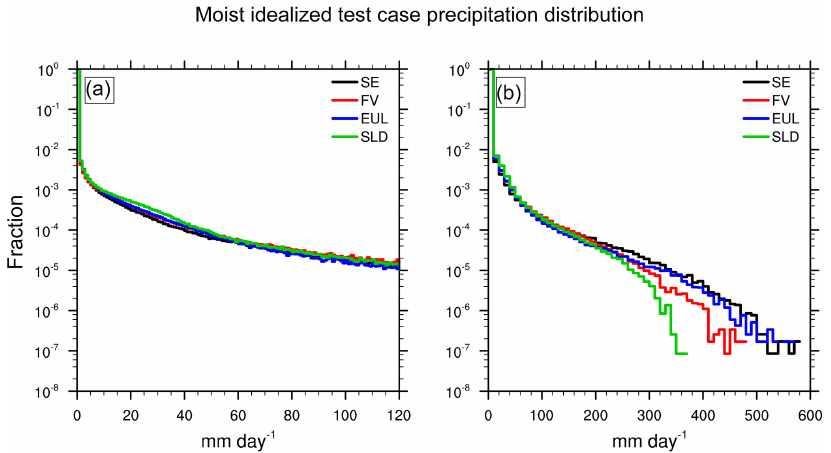
Figure 14. Frequency distributions of the MITC precipitation rates averaged between ± 10 ◦ for SE (black), FV (red), EUL (blue), and SLD (green). (a) Precipitation rates range from 0 to 120mmday − 1 with 1mmday − 1 bins, (b) precipitation rates range from 0 to 600mmday − 1 with 10mmday − 1